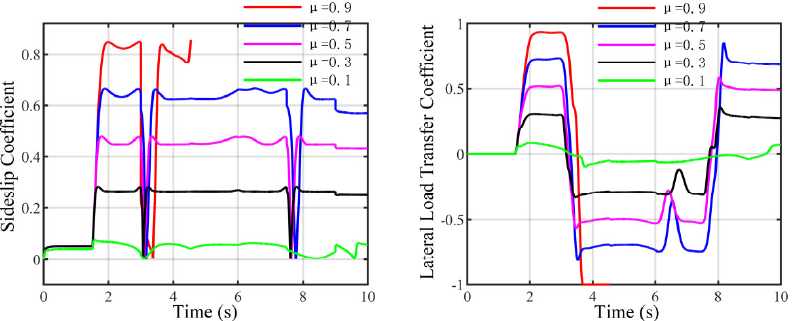
Figure 6. Comparison of ρ and the LTR under different road adhesion coefficients (Snake condition).